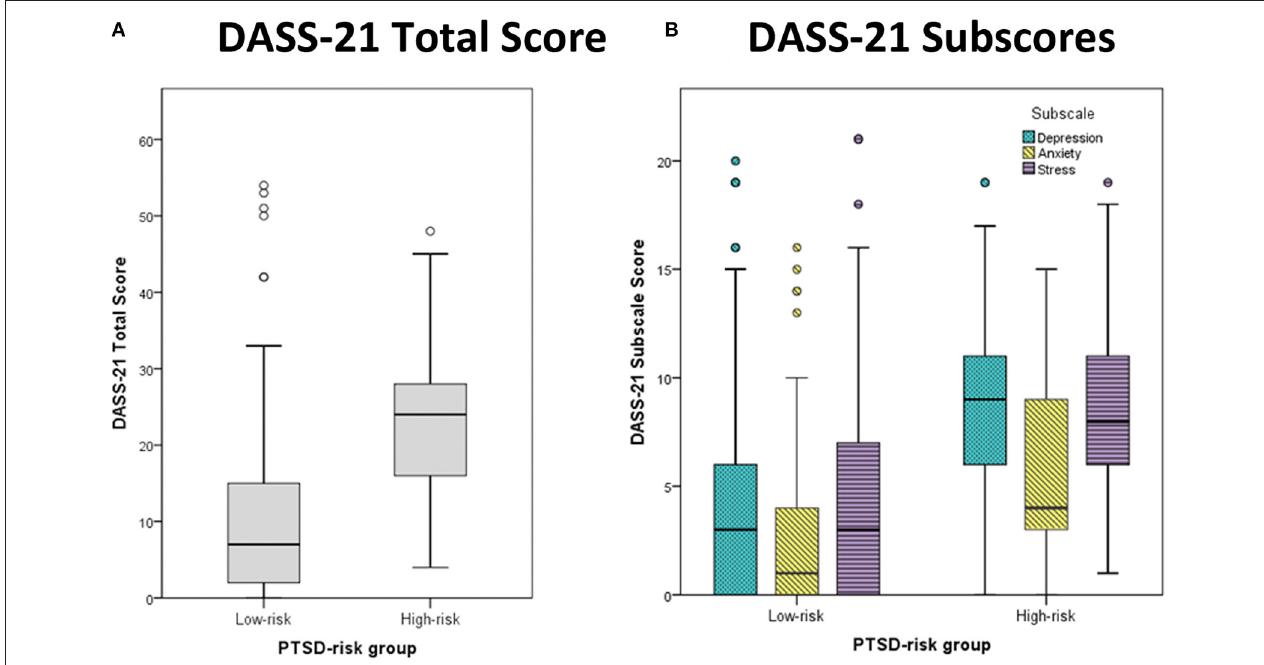
FIGURE 1 | Boxplots for (A) the total score and (B) the three subscores of the DASS-21. Median scores are provided for the two PTSD-risk groups (left: low-risk, right: high-risk). The different subscale scores are depicted for depression (cyan), anxiety (yellow), and stress (purple). Outliers are presented as small circles.